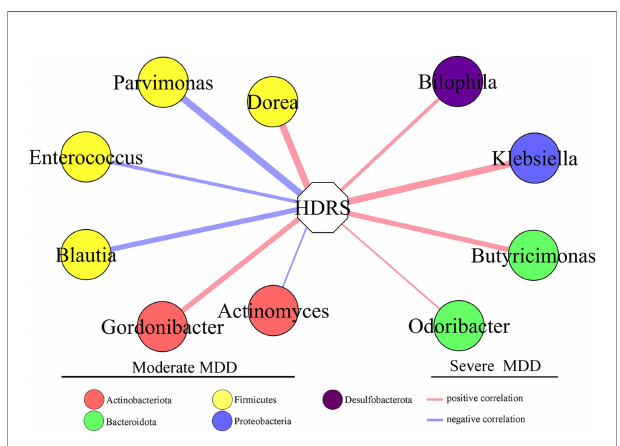
FIGURE 4 | Differential genera in moderate and severe MDD patients signi fi cantly correlated with HDRS. Six genera (four of them belonged to phylum Firmicutes) in moderate MDD patients were signi fi cantly positively or negatively correlated with HDRS. Four genera in severe MDD patients were signi fi cantly positively correlated with HDRS. MDD, major depressive disorder; HDRS, Hamilton Depression Rating